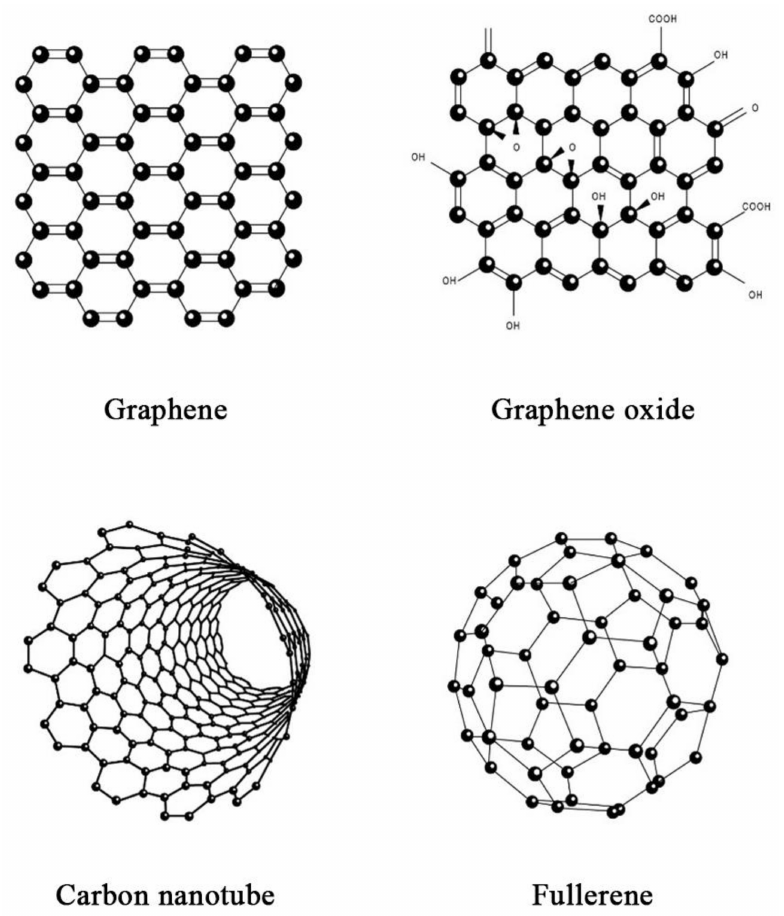
Figure 7. Structures of carbon-based